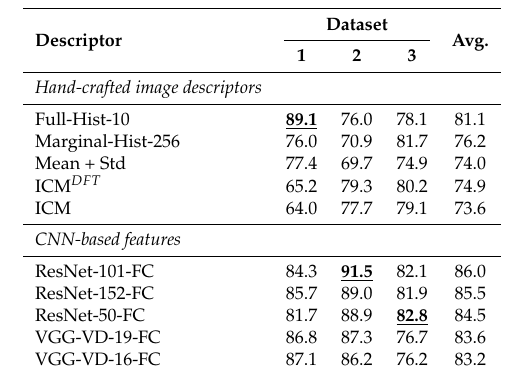
Table 13. Results of Experiment #7: stationary textures with variation in scale. Figures report overall accuracy by dataset. Boldface denotes the highest value; underline signals a statistically-significant difference between the best hand-crafted and the best CNN-based descriptor. Descriptors are listed in ascending order of by-experiment rank (best